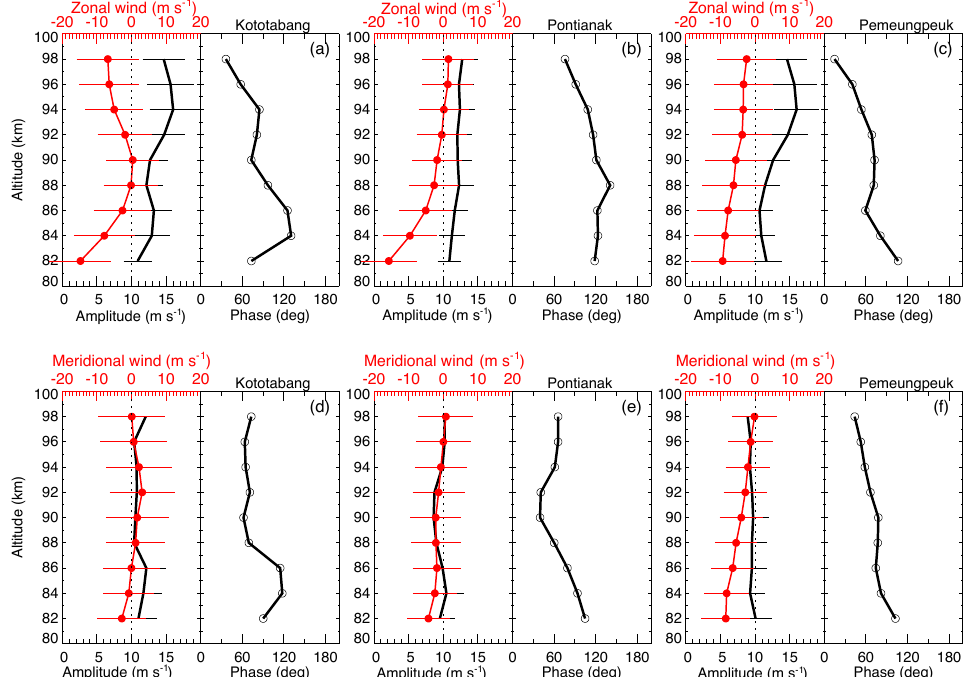
Figure 6. Height profiles of the amplitudes and phases (open circle) of the 6.5-day waves over Kototabang, Pameungpeuk, and Pontianak locations. The thick solid lines represent the mean zonal winds over the period from 1 April to 31 May